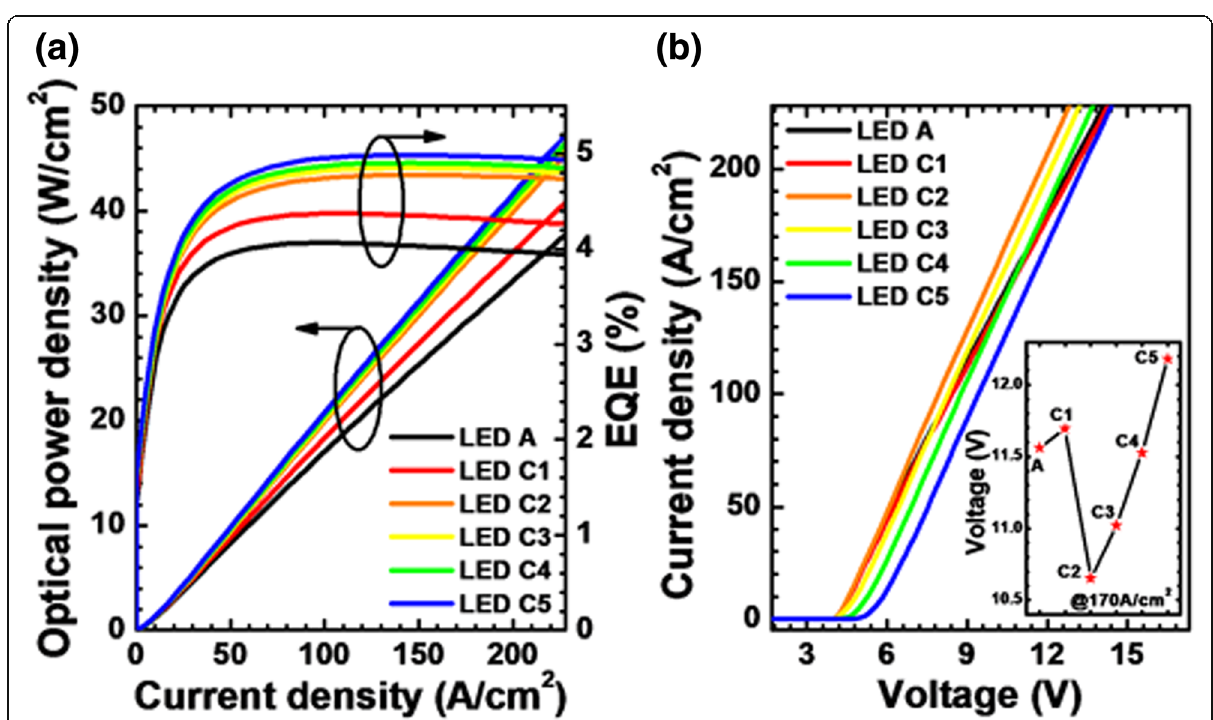
Fig. 7 a EQE and optical power density in terms of the injection current and b current-voltage characteristics for LEDs A and C i ( i = 1, 2, 3, 4, and 5). Inset: the forward voltages for LEDs A and C i ( i = 1, 2, 3, 4, and 5) when the current density is 170 A/cm